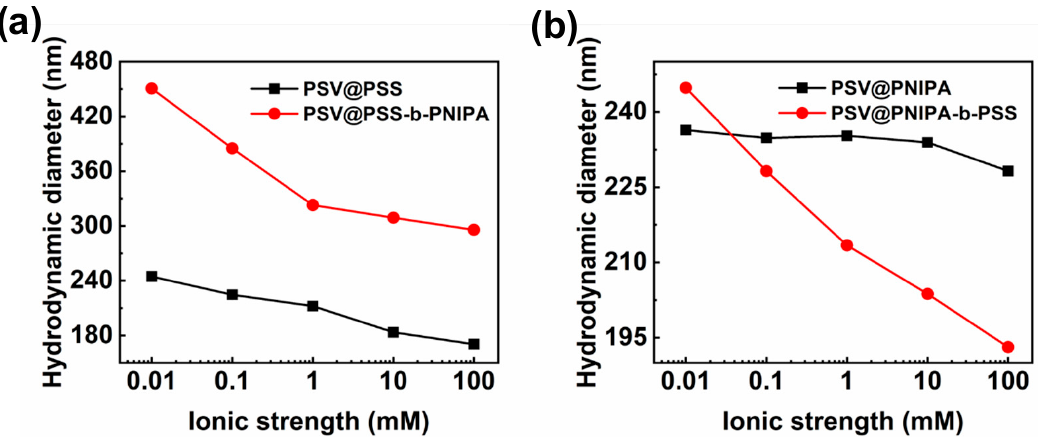
Figure 3. Particle size of ( a ) PSV@PSS, PSV@PSS-b-PNIPA, ( b ) PSV@PNIPA and PSV@PNIPA-b-PSS under different ionic strengths.